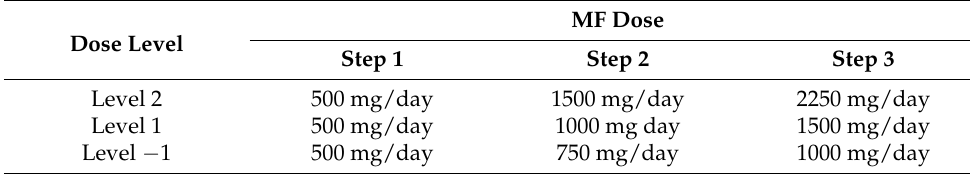
Table 1. MF dose-escalation